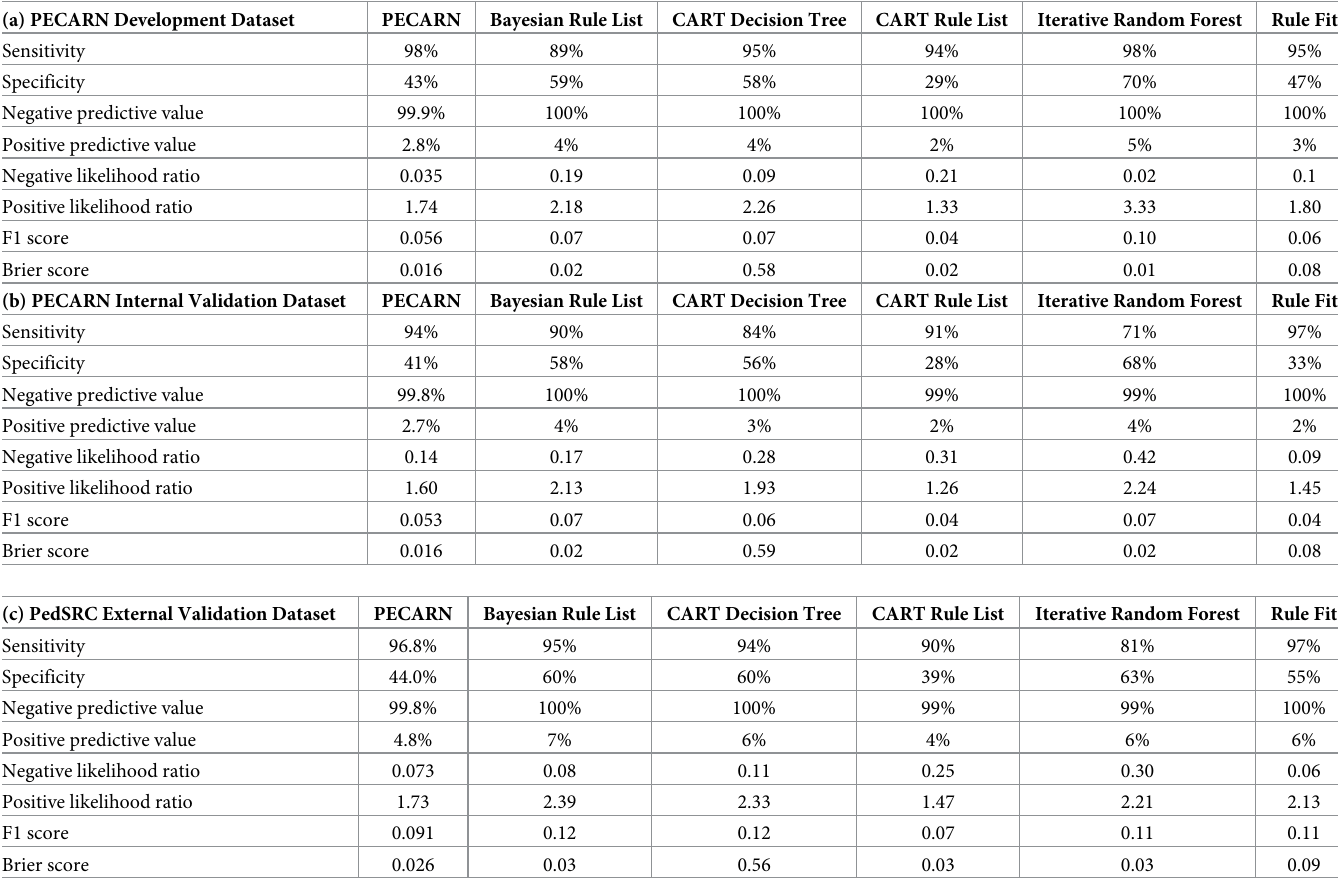
Table 2. Predictive performance of the clinical decision instruments with sensitivity weighted five times more heavily as specificity. (a) PECARN Development data- set, (b) PECARN Internal Validation Dataset, (c) PedSRC External Validation Dataset. (a) PECARN Development